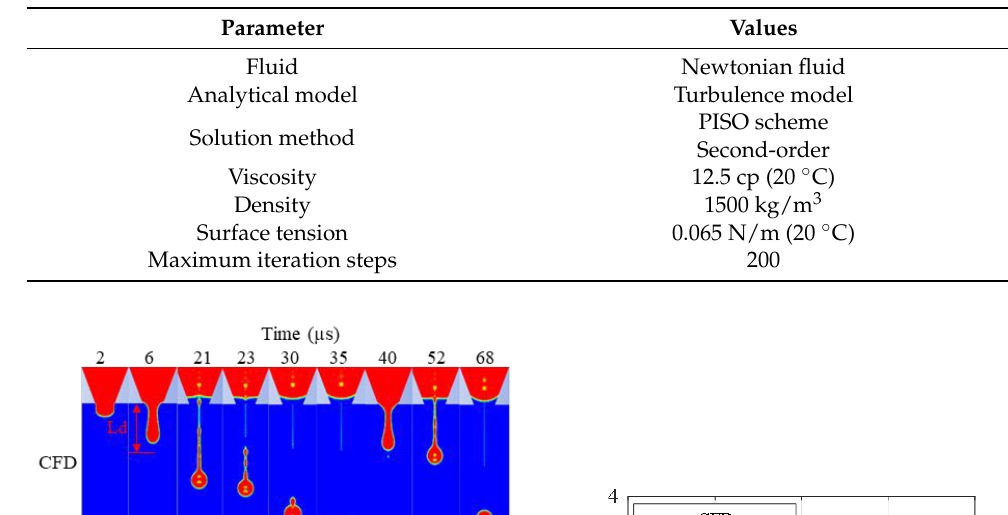
Table 2. Parameter settings for simulations.